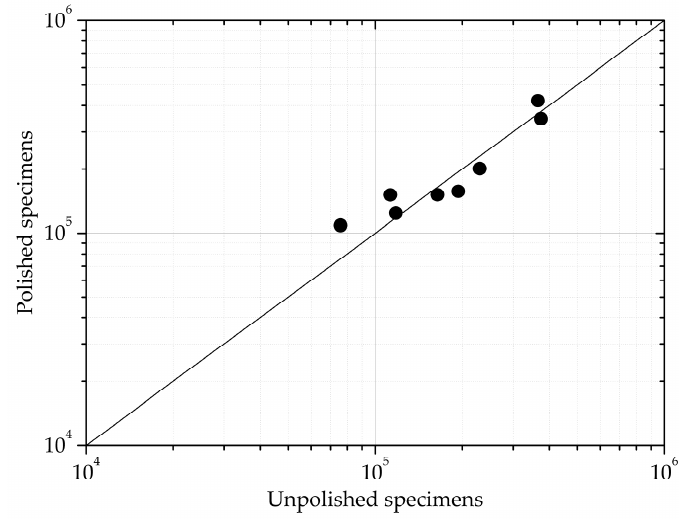
Figure 9. Comparison of fatigue lives in specimens treated with shot peening, both polished and unpolished.